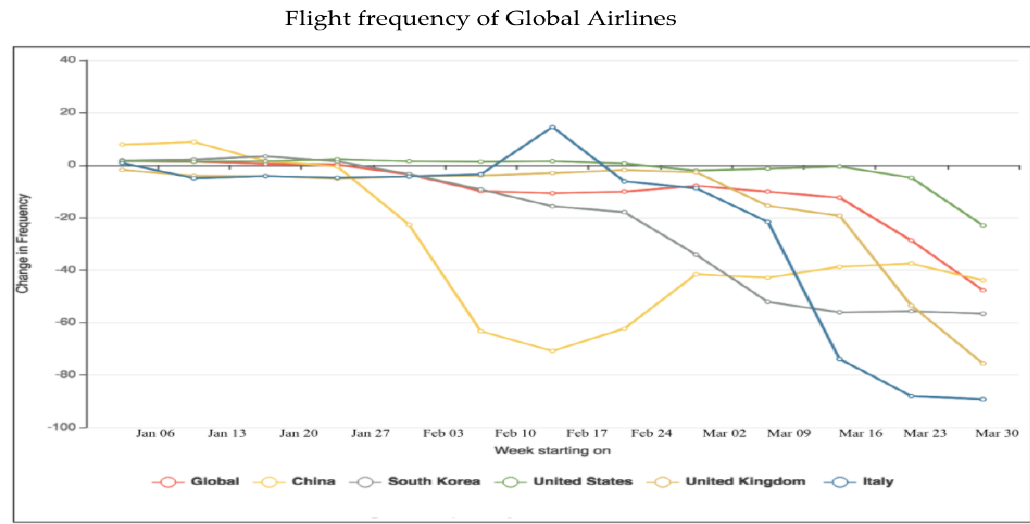
Figure 13. Change of flight frequency of global airlines due to the COVID-19 outbreak